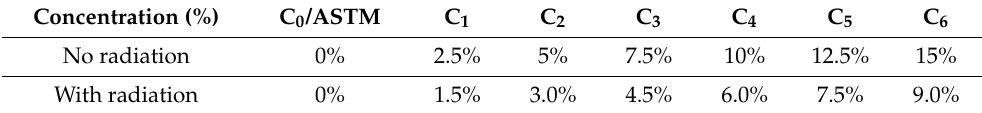
Table 1. Nominal concentrations (%) of dye solutions used in the evaluation of acute toxicity. Concentration (%) C 0 /ASTM C 1 C 2 C 3 C 4 C 5 C 6 No radiation 0% 2.5% 5% 15% With radiation 0% 1.5%